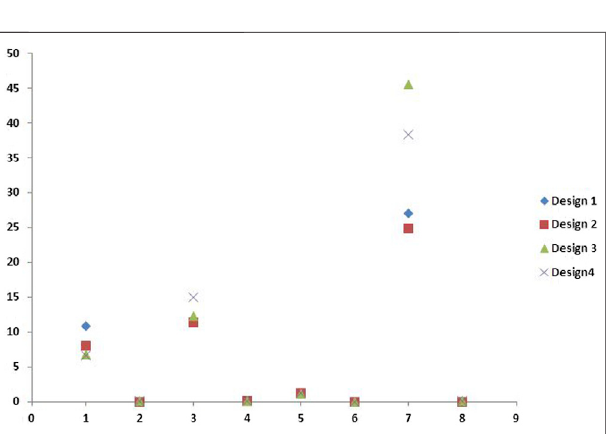
FIGURE 10 | Scatter diagram showing distribution stresses (in megapascals) on various components of different designs studied in the